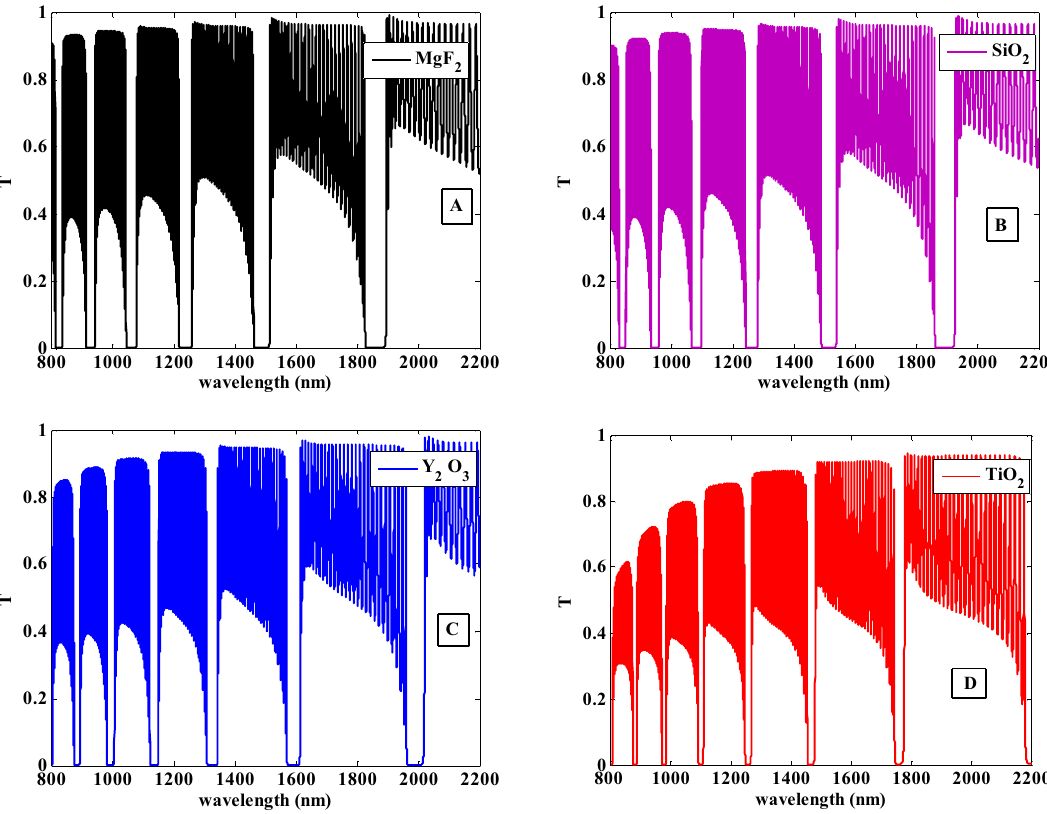
Figure 11. The transmittance spectra of the one-dimensional photonic crystal having HMM at different host